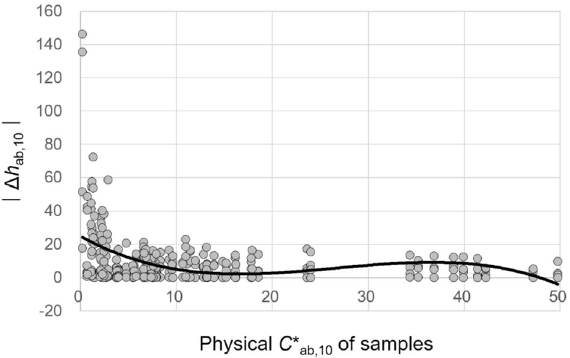
(cid:31) (cid:31) (cid:31) (cid:31) h ab ,10 (cid:31) , under illuminants.